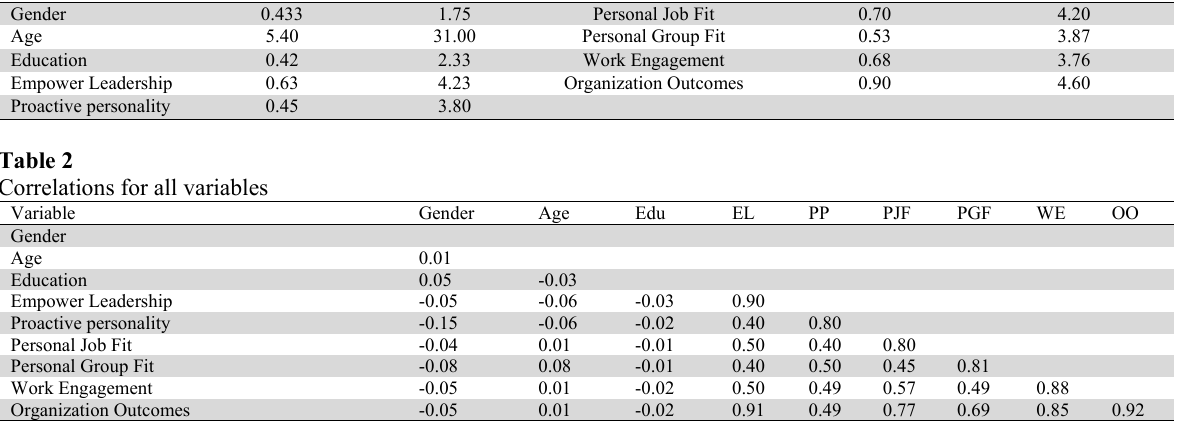
Means and standard deviations Variable